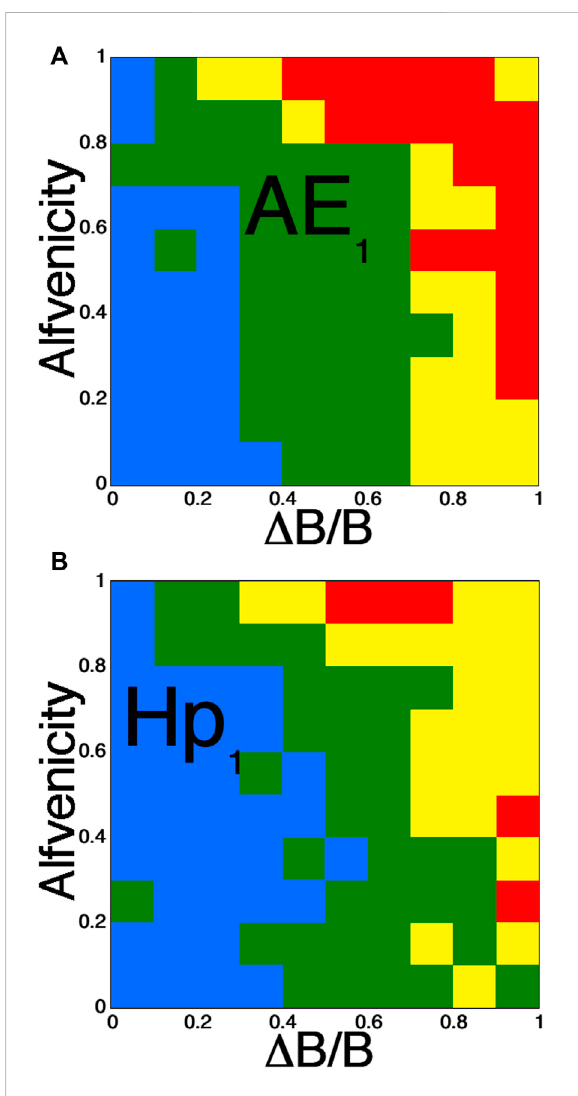
FIGURE 11 For times when R quick is in the lowest 20% of its values, the AE index and the Hp60 index are binned according to the values of Δ B/B and the Alfvénicity |A|. Panel (A) denotes the mean value of AE 1 in each bin: red (AE 1 > 100 nT), yellow (75 < AE 1 < 100) green (50 < AE 1 < 75), and blue (AE 1 < 50 nT). Panel (B) denotes the m an value of Hp60 1 in each bin: red (Hp60 1 > 2), yellow (1.5 < Hp60 1 < 2), green (1 < Hp60 1 < 1.5), and blue (Hp60 1 <